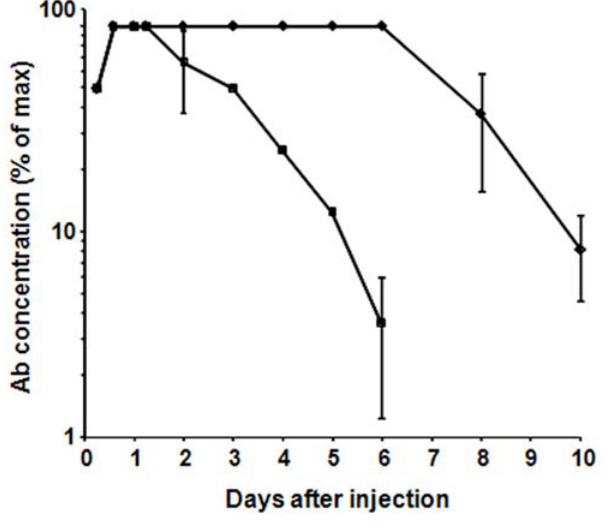
Figure 5. Circulatory clearance profiles of cAb 29 and mAb 29. Guinea pigs (n=3 for each group) were i.m. administered with 5 mg/kg of either cAb 29 (diamonds) or mAb 29 (squares). Blood samples drawn at various time points were assayed for Ab concentration by ELISA. Mean 6 STD values are presented as percentages of maximum blood levels (C max